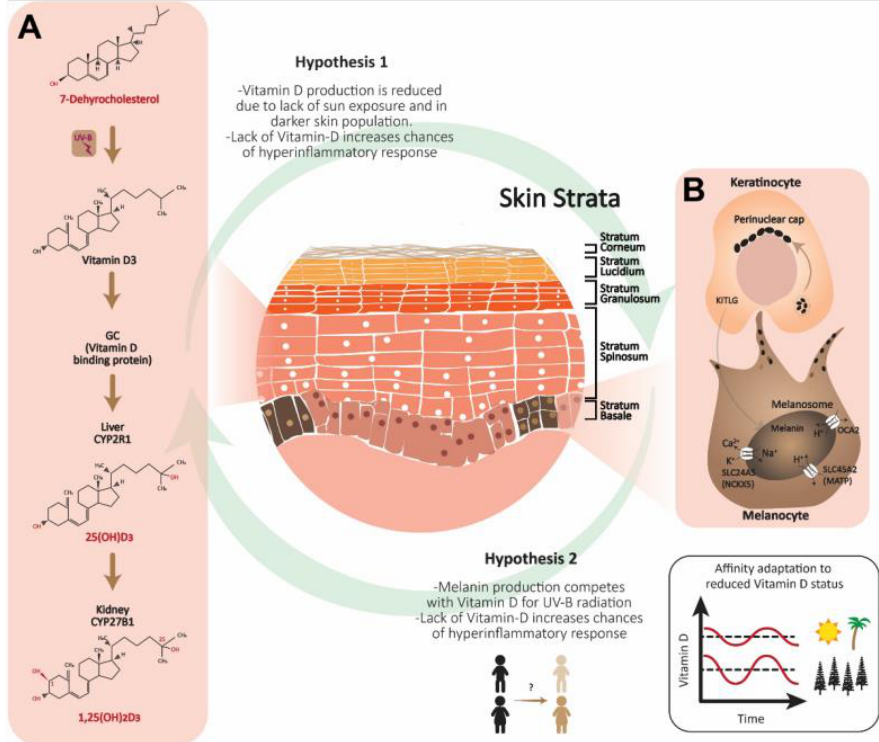
Figure 3. Diagrammatic illustration of the interplay between vitamin D synthesis and pigmentation biology within the skin strata. ( A ) Vitamin D 3 is synthesized when cholesterol precursor 7-dehydrocholesterol is exposed to UV-B radiation in a non-enzymatic conversion, which then initially synthesizes pre-vitamin D that eventually isomerizes to vitamin D3. Vitamin D 3 and associated metabolites in serum are bound to GC protein and transported to the liver. The liver enzyme CYP2R1 converts vitamin D 3 to 25(OH)D 3 . In the kidneys, CYP27B1 synthesizes 1,25(OH) 2 D 3 , which has a high affinity towards vitamin D cell surface receptors. ( B ) Melanocyte cells residing in the basal layer of the epidermis provide keratinocyte cells with melanosomes. Keratinocyte cells phagocytose melanosomes and reorganize in the supranuclear area to form melanin caps. Under the process of melanogenesis, melanin is synthesized in melanosomes under the control of the proteins KITLG, SLC24A5, and SLC45A2. The complete hypothesis of the figure explains the interplay between vitamin D production with